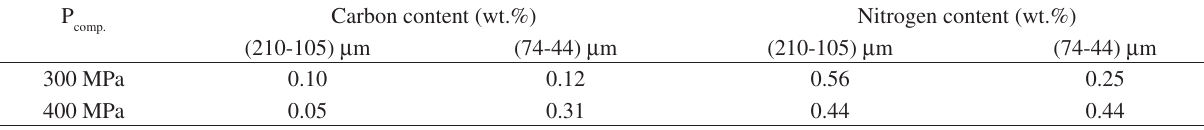
Table 2. Carbon and nitrogen contents in the 316 SS filters. P comp.